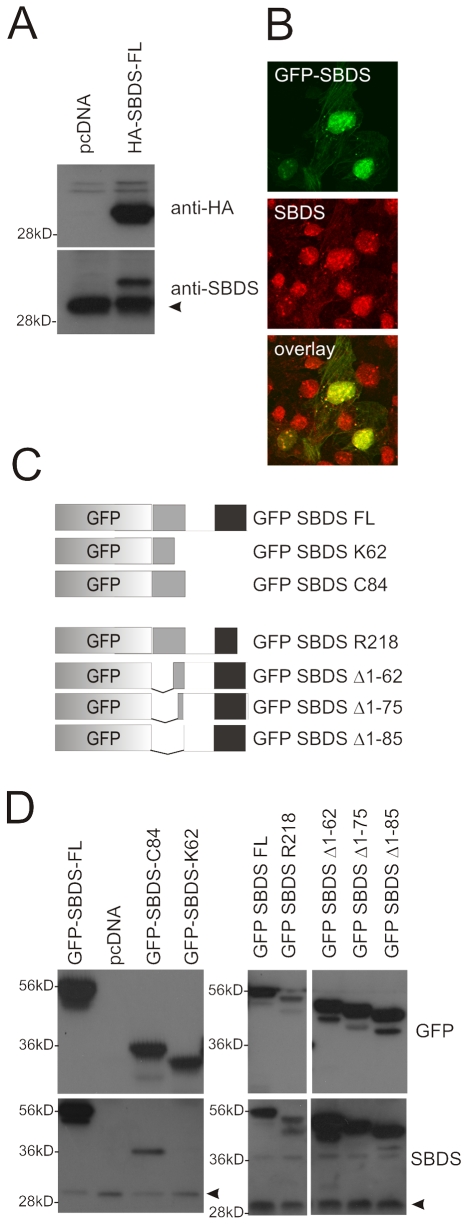
Generating SBDS Antibody.To test specificity of our SBDS antibody we overexpressed GFP- or HA-tagged SBDS in HeLa or Cos-7 cells (A) Western blotting shows that the anti-HA antibody recognizes a 30–34 kD protein in HA-SBDS-FL transfected Cos-7 cells. In a duplicate blot we show that our SBDS antibody recognizes specifically a 30–34 kD protein in HA-SBDS transfected cells. Moreover, we detected an approximately 30 kD band, which represents the endogenous SBDS. (B) Immunostaining with our SBDS antibody shows that GFP-SBDS expression (green; top picture) and endogenous stained SBDS (red; middle picture) coincides in Cos-7 cells (bottom picture). (C) Schematic overview GFP-SBDS constructs used for transient transfection followed by Western blotting analysis. The grey, white and black regions indicate the three main SBDS protein regions, namely an N-terminal FYSH domain, a central helix-turn-helix motif and the C-terminal common fold which has homology with a RNA-Recognition Motif (RRM). (D) Western blot analysis for several GFP-SBDS protein isoforms transiently expressed in HeLa cells. GFP staining (top panel) shows that these constructs are expressed at expected molecular weight and staining with our SBDS antibody shows that the antibody recognizes GFP-SBDS-FL, R219, C84 and the N-terminally truncated SBDS isoforms (GFP-SBDS Δ1–65, Δ1–75 and Δ1–85), but not GFP-SBDS-K62. Protein standard indicates protein size as indicated (56 kD, 36 kD and 28 kD, respectively)